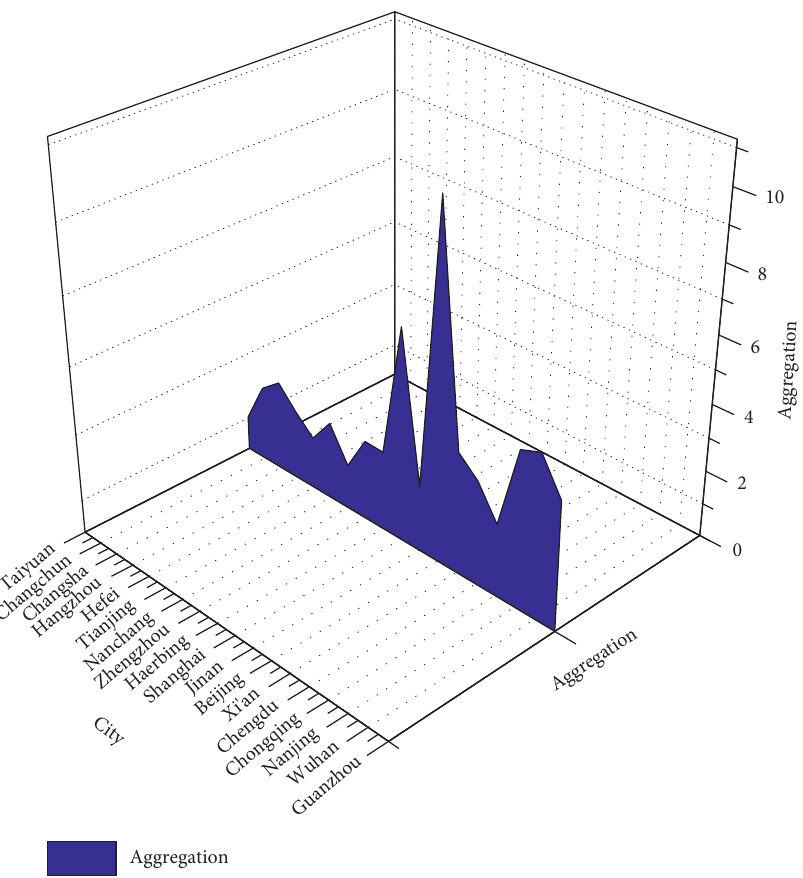
Figure 7: Map of higher education resource concentration level